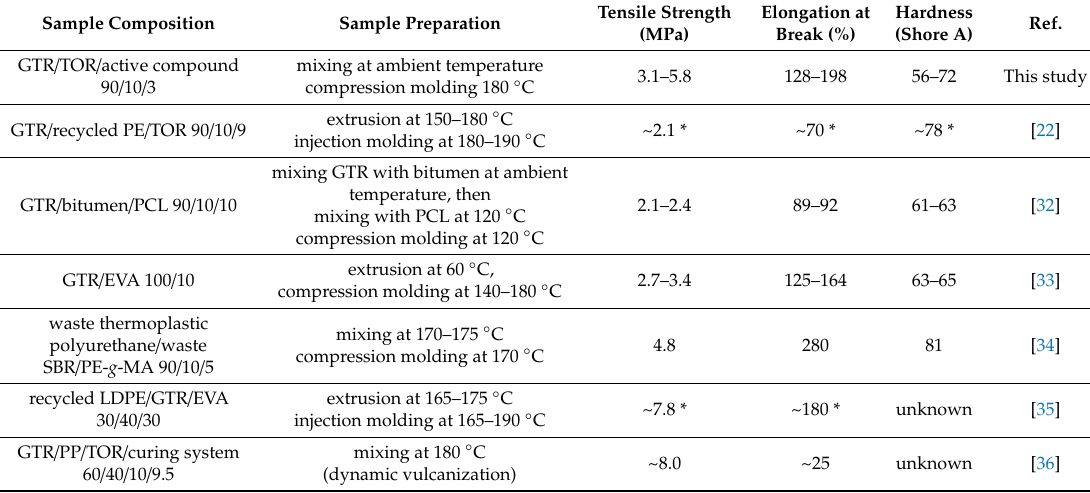
Table 5. Physico-mechanical properties of GTR-based blends reported by di ff erent groups and previous